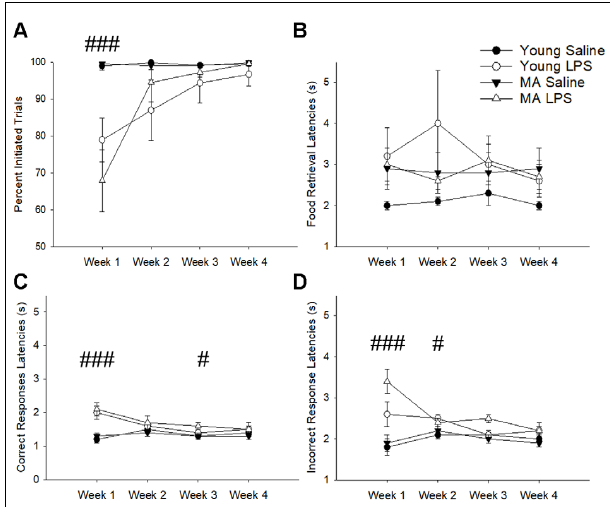
FIGURE 2 | Despite transient sickness behavior, cognitive slowing was characteristic of latter weeks in LPS-treated rats. The first exposure to LPS induced significant sickness behavior effects, marked by a lack of motivation to perform the task as indicated by a reduction in initiated trials (A) . To determine if LPS hindered the physical capacity to move, food retrieval latency was analyzed across weeks. This measure did not significantly change between groups (B) . Conversely, LPS treatment increased correct response latencies for the first and third weeks (C) and incorrect response latencies for the first and second weeks (D) , suggesting an overall slowing of cognitive processes without any motor impairment in response to chronic LPS treatment. Data are presented as means ± standard error of the mean (SEM). ### p < 0.001, # p < 0.05 for week by treatment